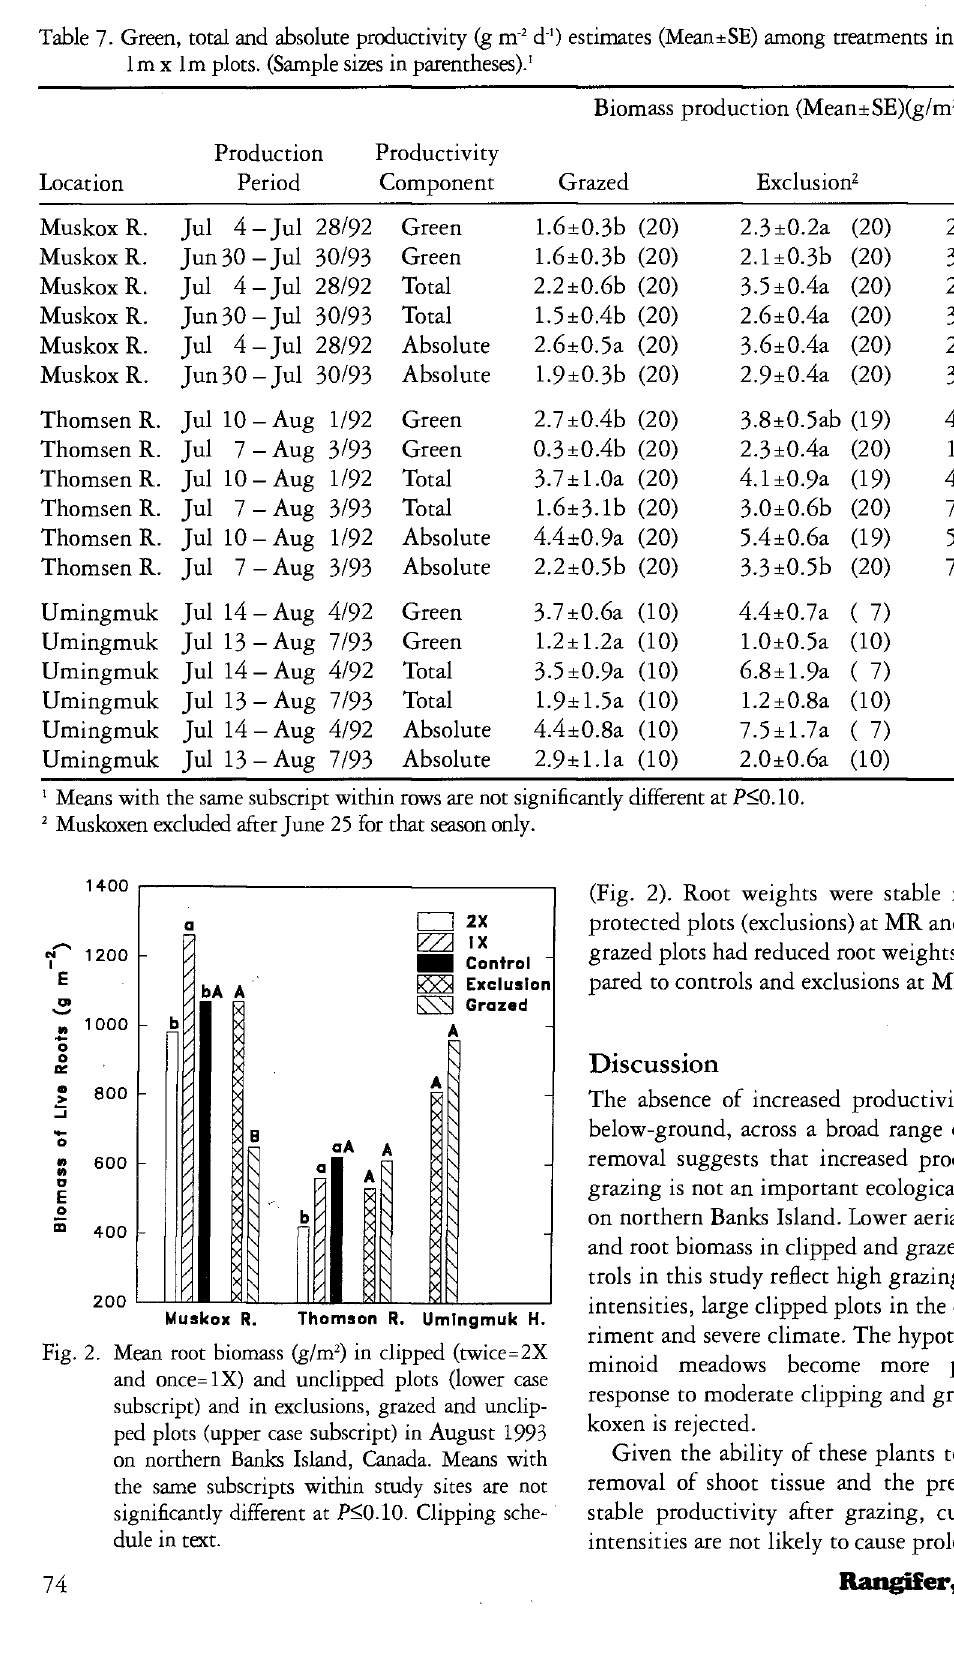
Table 7. Green, total and absolute productivity (g m~ 2 d 1 ) estimates (Mean±SE) among treatments in 1992 and 1993 lm x lm plots. (Sample sizes in parentheses). 1